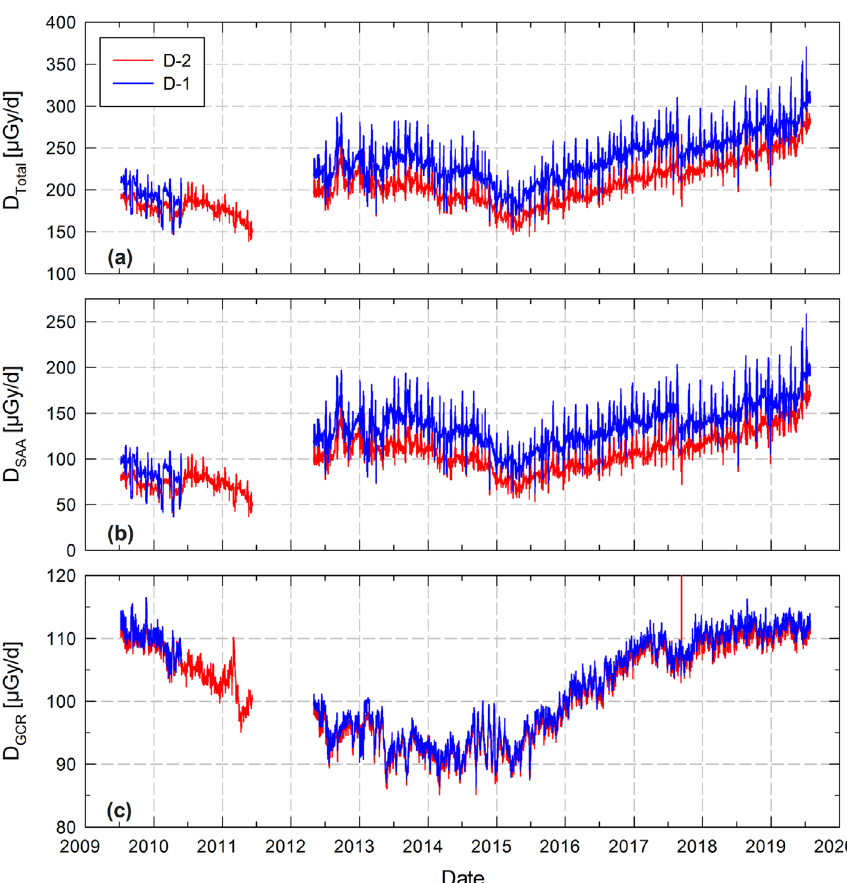
Fig. 7. (a) Total daily dose measured with D-1 (blue) and D-2 (red); (b) SAA contribution to the daily dose; and (c) GCR contribution to the daily dose.